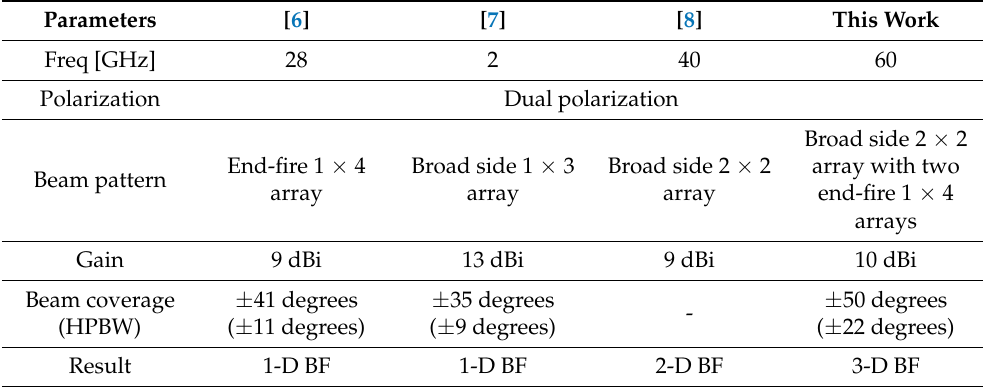
Table 2. Comparison with